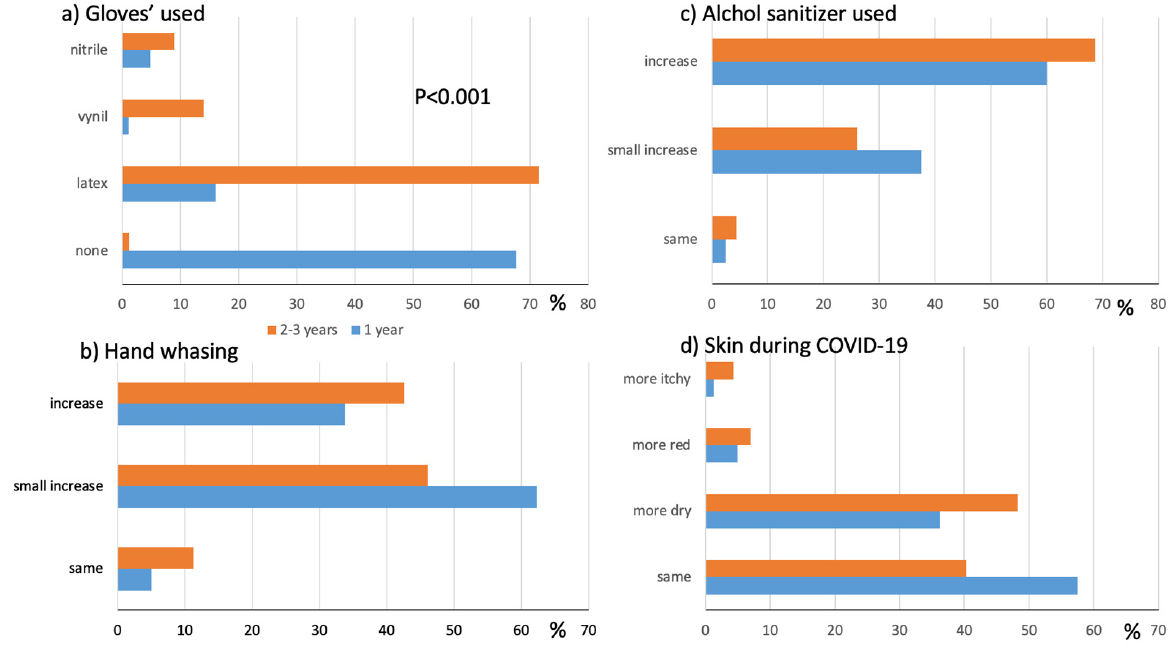
Figure 3. Impact of COVID-19 pandemic. Glove preferences ( a ), modification of hygiene habits ( b ), use of alcohol-based sanitizers ( c ), perception of own skin condition ( d ) in 1st-year and 2nd–3rd- year students. The COVID-19 pandemic affected the habits of the apprentice nurses (Figure